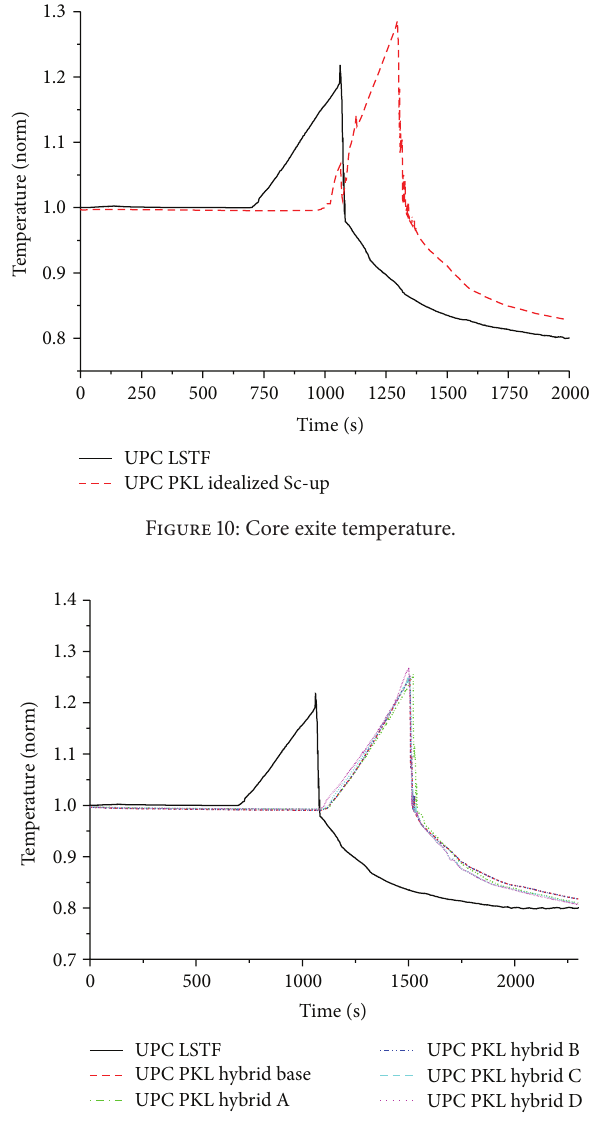
Figure 11: Core exite temperature.